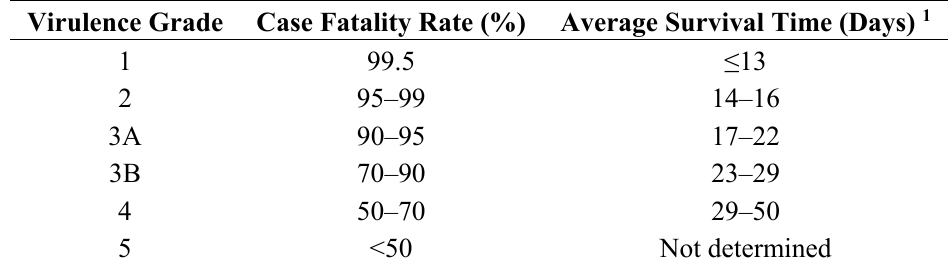
Table 5. Virulence grades of